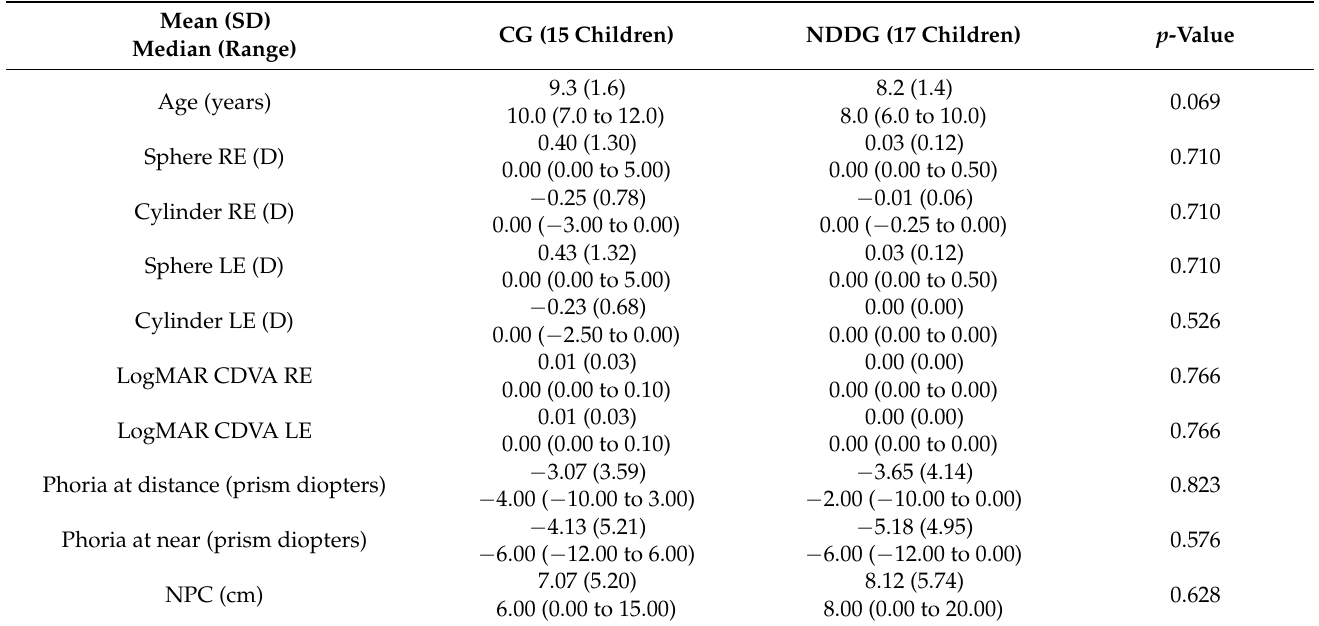
Table 2. Summary of the main characteristics of the two groups involved in the study: CG, control group, and NDDG, neurodevelopmental disorder group.